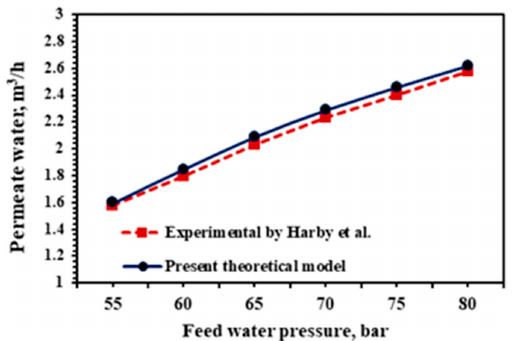
Figure 3. Model validation of the RO desalination unit [34].